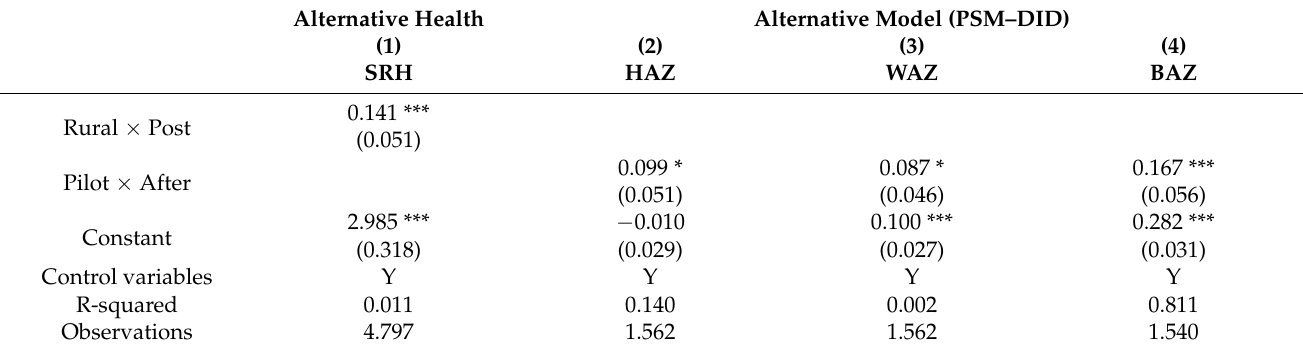
Table 4. Robustness checks for different indicators and estimation methods.